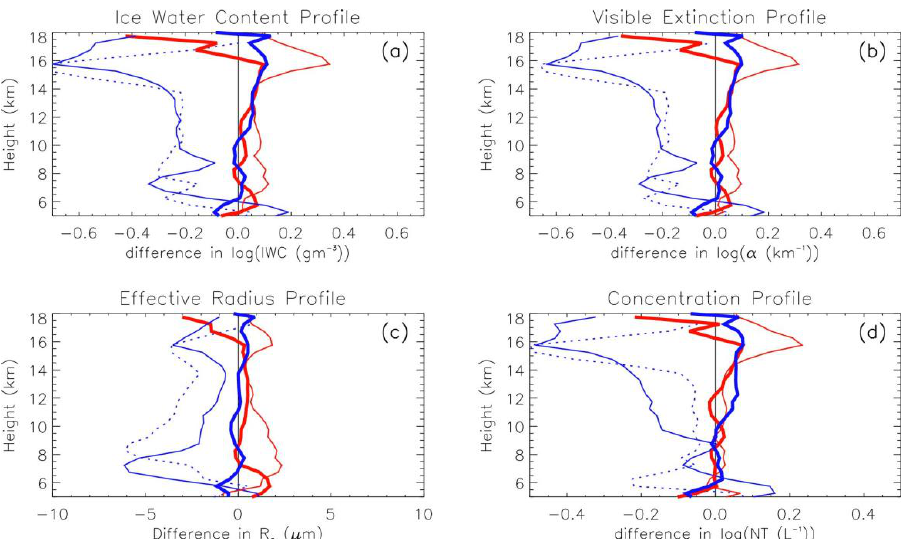
Figure 8: Mean vertical profiles of the difference (regime-total) in microphysical and radiative properties of